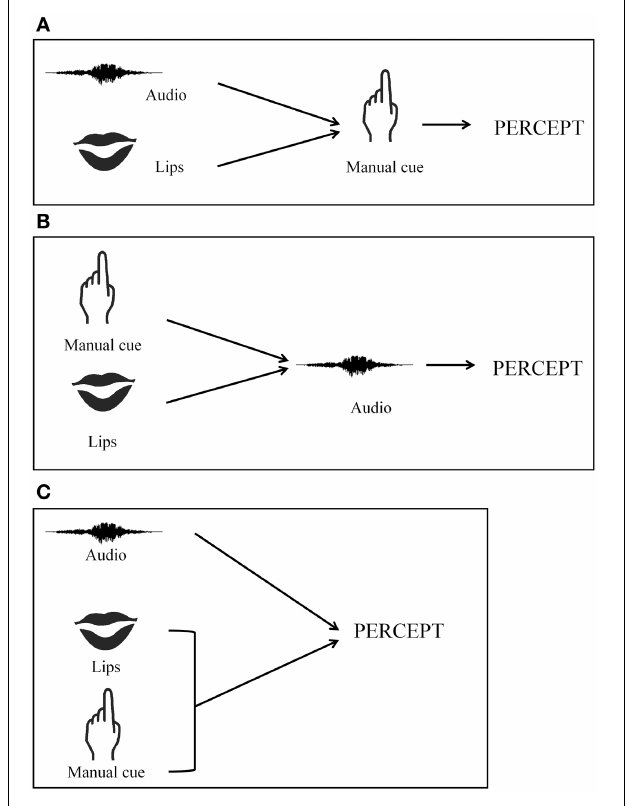
FIGURE 3 | CS perception models. (A) Sequential model with late integration of manual cue; (B) Sequential model with early integration of manual cue; (C) Simultaneous model with early integration of manual